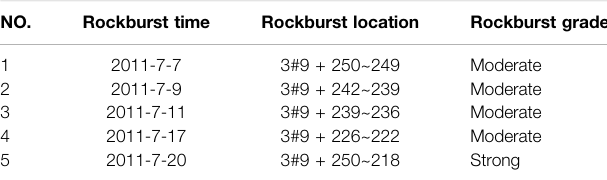
TABLE 4 | Basic situation of rockburst in 3 # diversion tunnel.